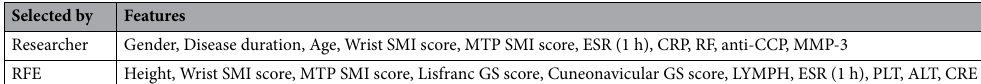
Table 4. Comparison of the researcher/RFE-selected features. In RFE-selected features, those selected in XGBoost were shown. SMI superb microvascular imaging, ESR erythrocyte sedimentation rate, CRP C-reactive protein, RF rheumatoid factor, CCP cyclic citrullinated peptide antibody, MMP-3 matrix metalloproteinase-3, RFE recursive feature elimination, MTP metatarsophalangeal, LYMPH lymphocyte count, PLT platelet count, ALT alanine aminotransferase, GS gray scale, CRE creatinine.